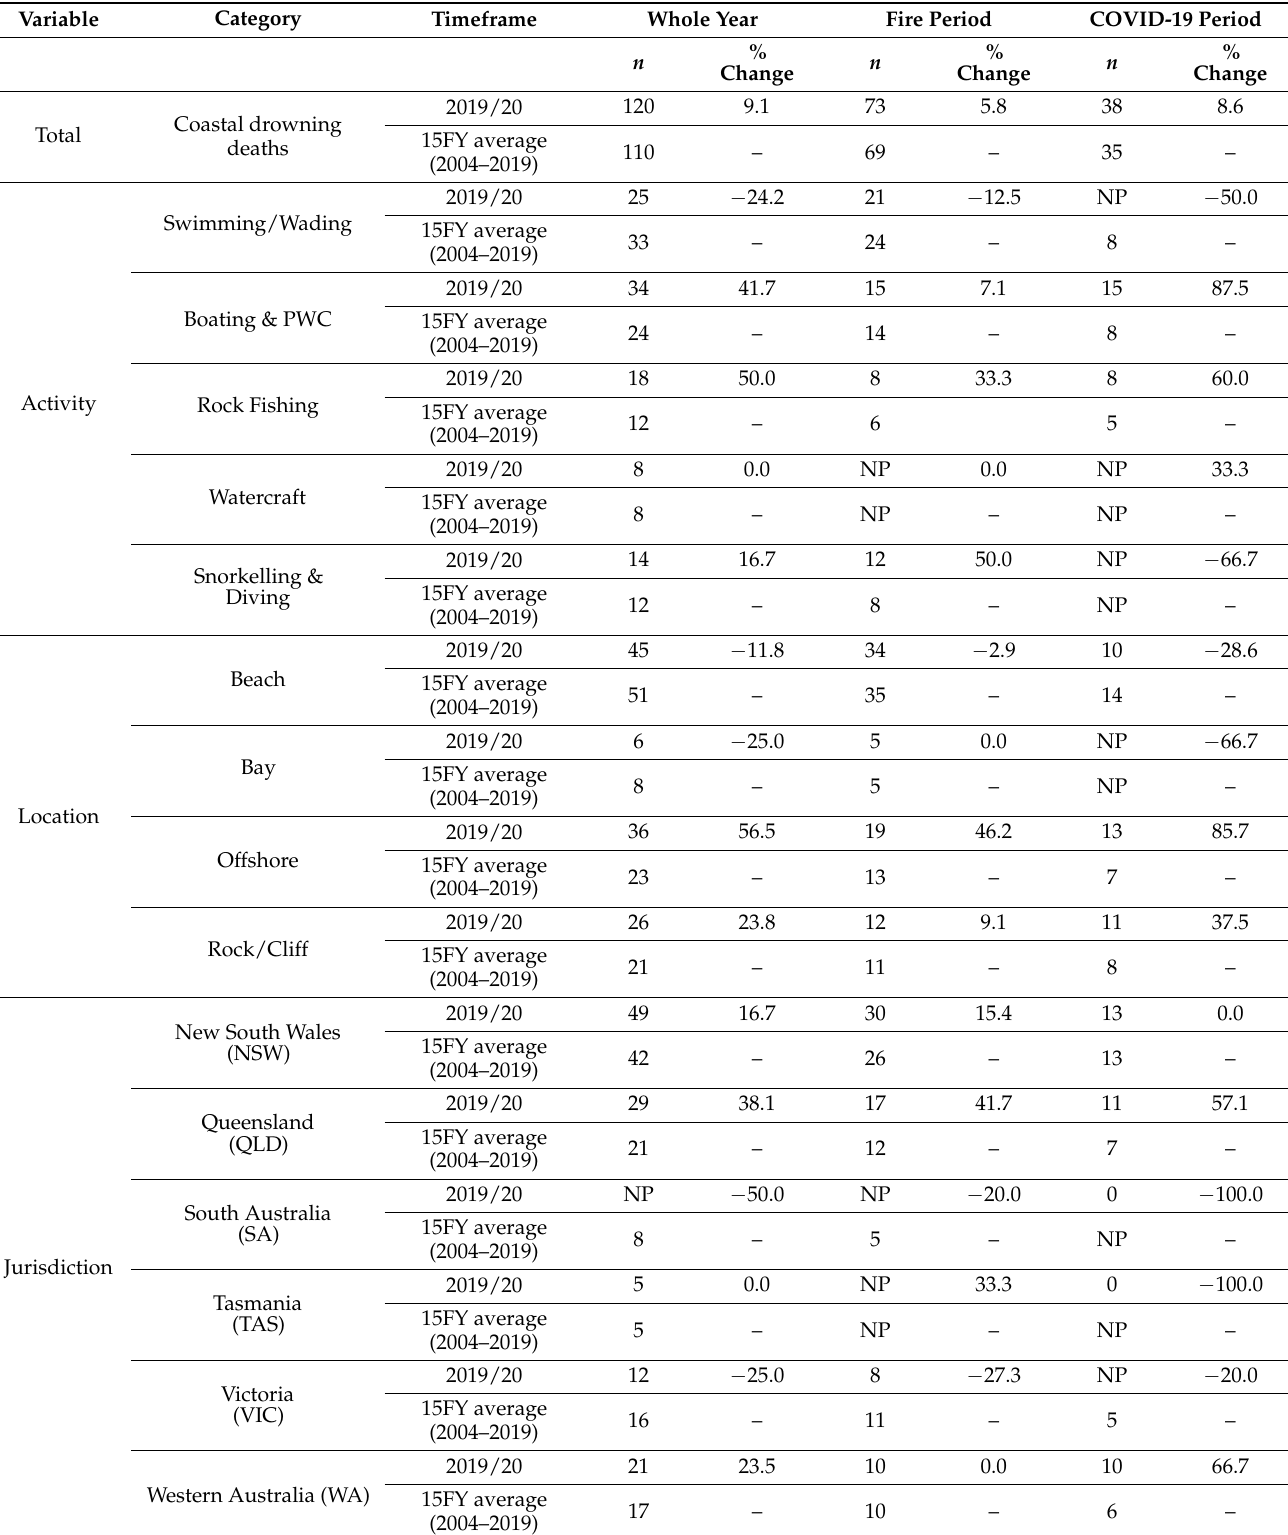
Table 2. Numbers and percentage change of drowning deaths recorded in three determined periods of interest compared with 15-year (15FY) average for Australian coastal jurisdictions Variable